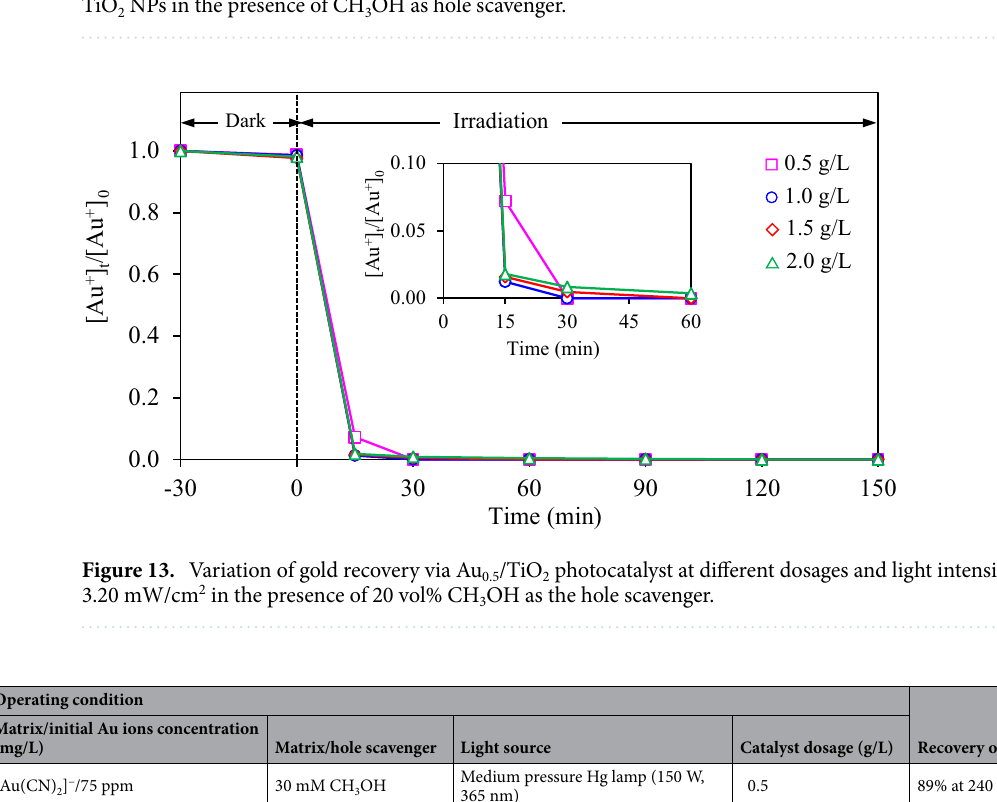
Figure 12. Possible mechanism of photocatalytic gold recovery from gold-cyanide containing solution over Au/ TiO 2 NPs in the presence of CH 3 OH as hole scavenger.